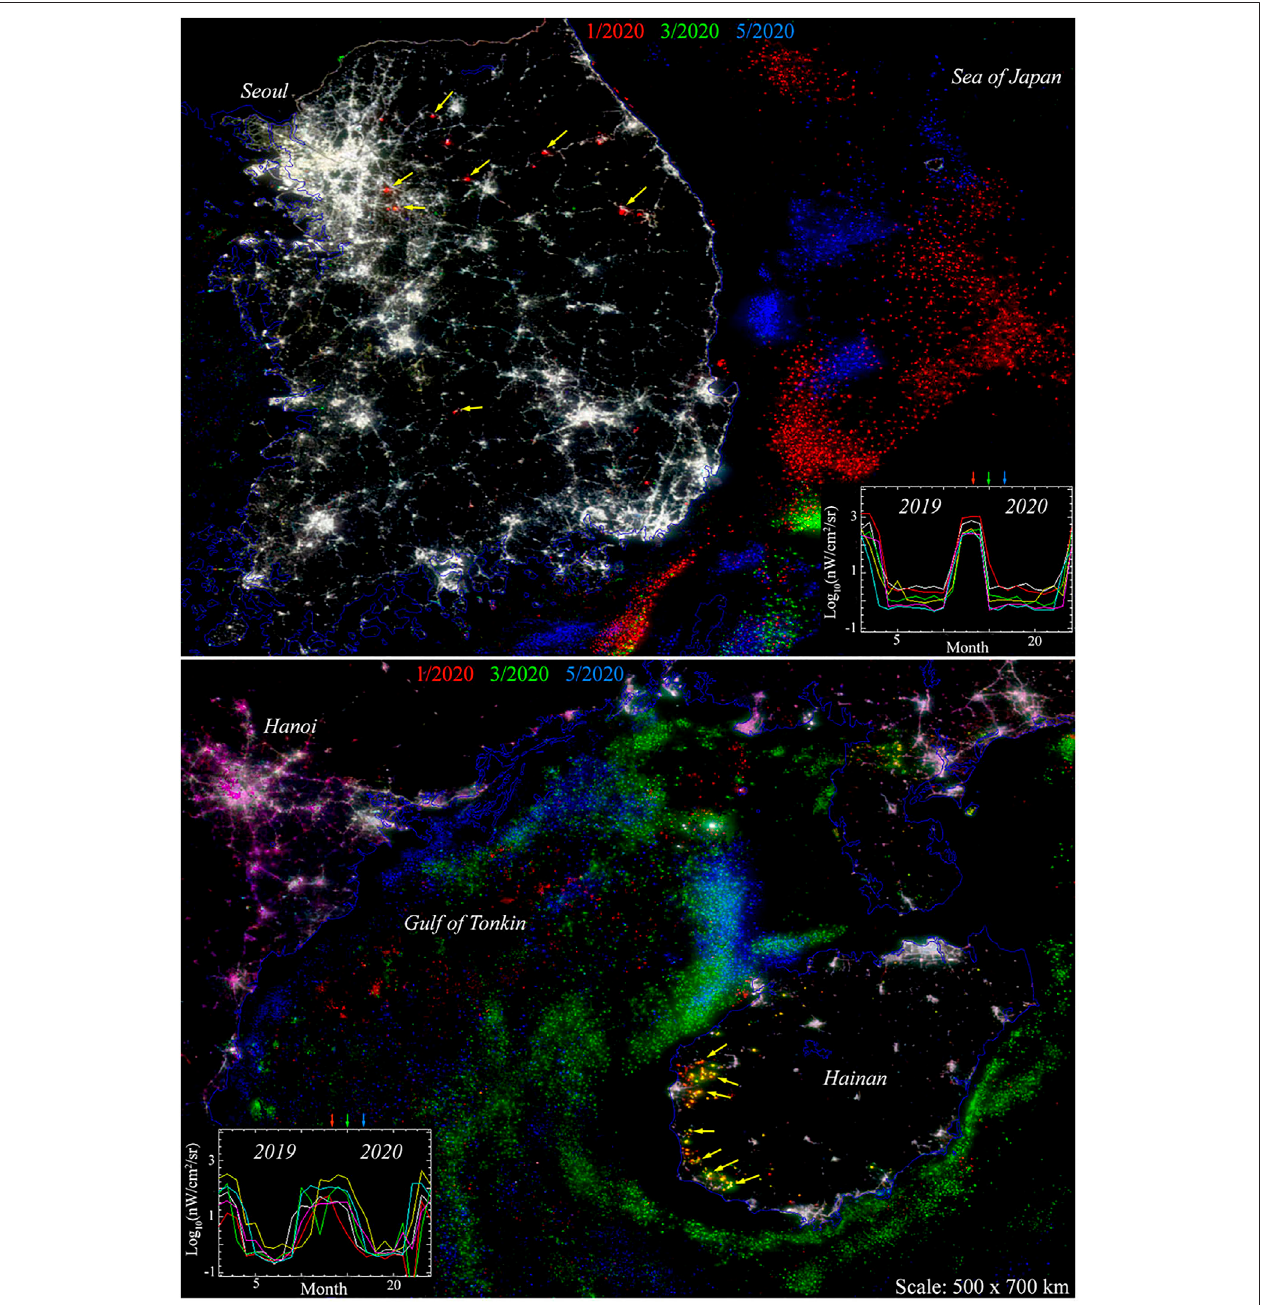
FIGURE 8 | Seasonal night light in coastal east Asia. Tri-temporal composites of monthly mean radiance for early 2020 shows most urban lights as unchanging (shades of gray). Color implies change. Warmer colors imply dimming between January and May 2020. Small isolated sites with seasonal fl uctuations in northern South Koreaand westernHainanIslandoccurin2019and 2020(arrowsand insetplots).More prominentaretheseasonal movements of fi shing fl eetsintheSea ofJapanand Gulf of Tonkin. The apparent change in Hanoi and other Red River Delta cities results from cloud cover reduced brightness in March 2020.